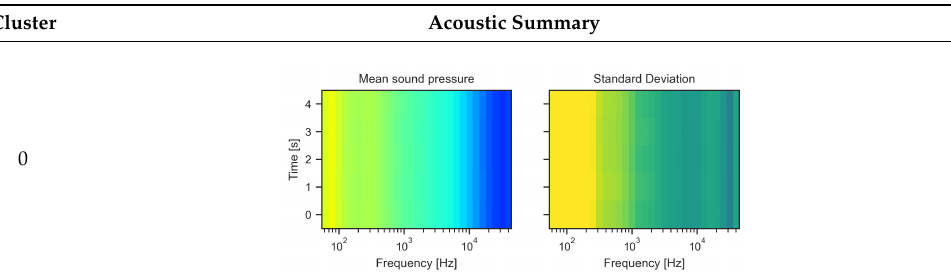
Table A5. Mean and standard deviations of the values of the one-third octave bands, in time per each